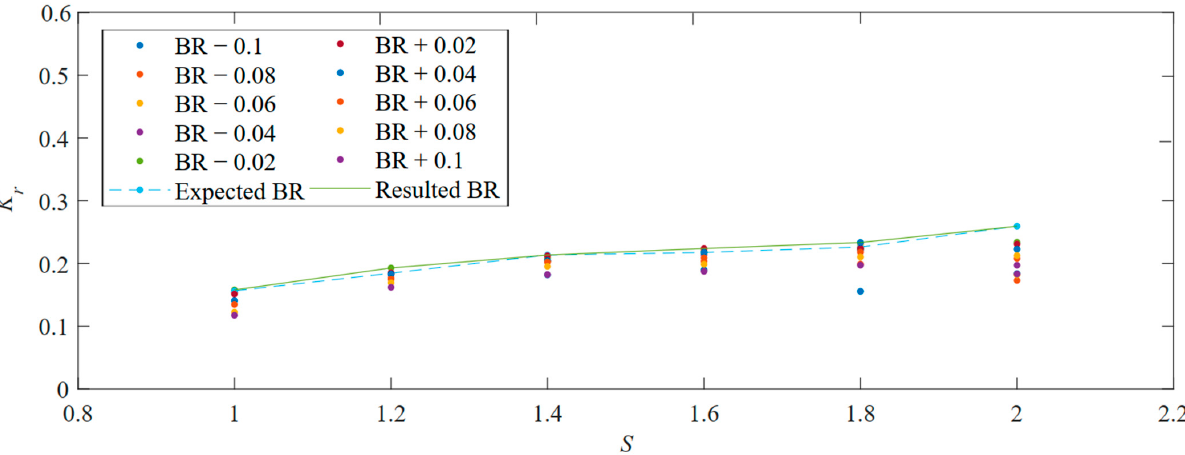
Figure 6. Bragg resonance of 2 periodically submerged breakwaters along different structural wave- lengths at 0.2 m water depth.